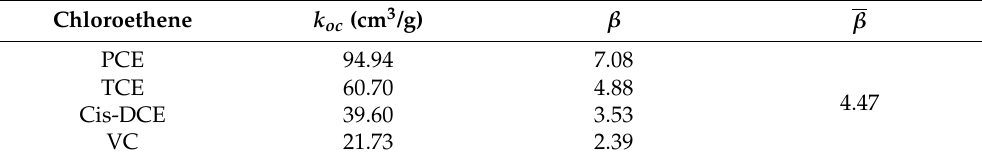
Table 3. Representative value of the partition coefficient between organic carbon and water ( k oc ) and retardation factors ( β ) for chloroethenes. β is the average retardation factor.